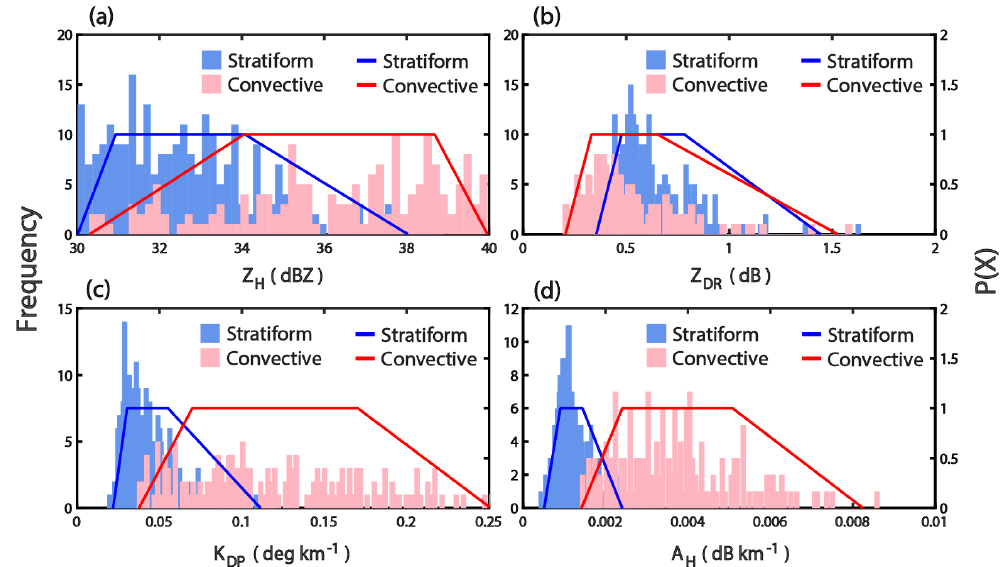
Figure 13. Same as Figure 12, but for intercept of Z H between 30 and 40